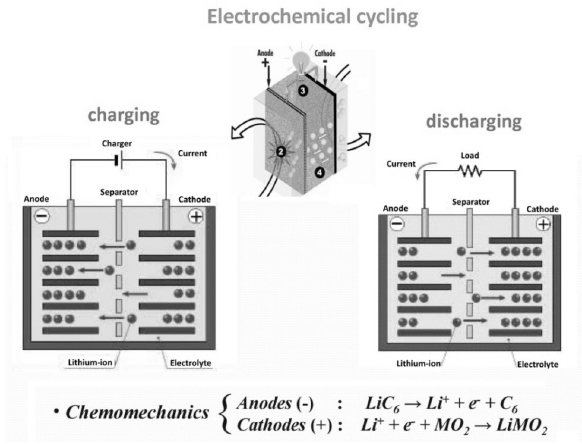
Figure 1: Typical electrochemical cell and Li reactions. Commercial graphite (C) is experimentally being replaced by Sn or Si. C gives a capacity of 370 mAh/g (LiC 6 ); Sn gives a capacity of 990 mAh/g (Li 4.4 Sn) and Si gives a capacity of 4200 mAh/g (Li 4.4 Si). The result- ing volume expansion can reach 300-400%. [Courtesy of Katerina E.